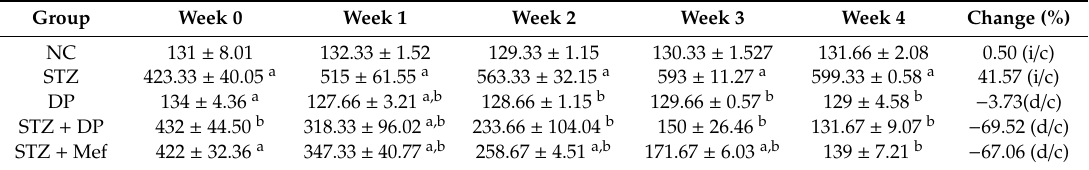
Table 3. E ff ect of Dendropanax (DP) on blood glucose level in diabetic-induced nephrotoxicity rats after 28 days of